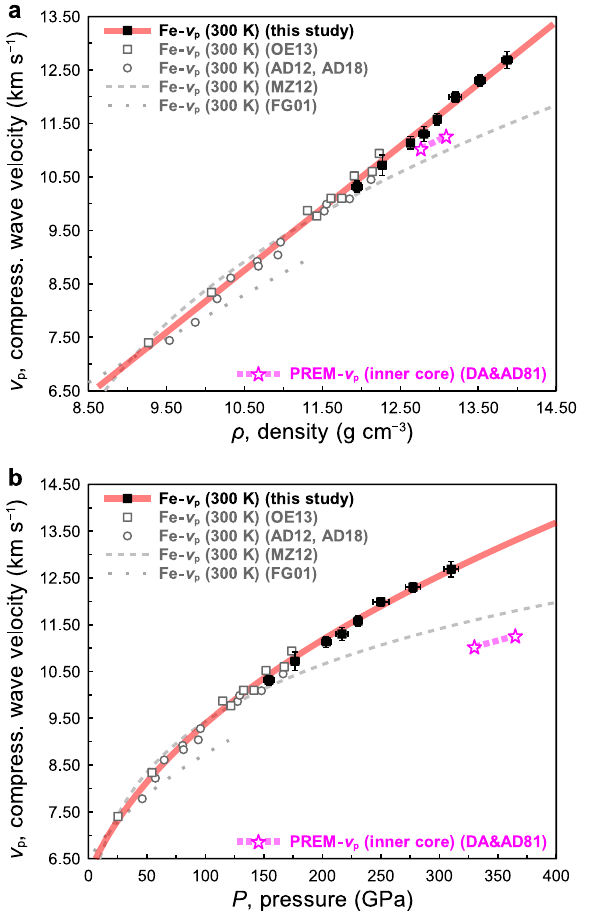
Fig. 2 | Compressional wave velocity ( v p ) of hexagonal close-packed (hcp) iron at high pressure. a The v p ‒ ρ relation of hcp-iron at ambient temperature. Solid squaresaretheresultsofthiswork;opensquaresfromOhtanietal.(OE13) 8 ;circles from Antonangeli et al. (AD12, AD18) 6,10 ; a dashed curve extrapolated by a power- lawrelationfromMaoetal.(MZ12) 7 ;andadottedcurvefromFiquetetal.(FG01) 5,11 . The magenta dashed curve with stars is the Preliminary reference Earth model (PREM) inner core (DA&AD81) 1 . b The pressure dependency of v p of hcp-iron at ambient temperature. The pressures were evaluated by the equation of state of hcp-iron by Dewaele et al. 3 The symbols are the same as those in Fig. 2a. The error bars represent 1 σ